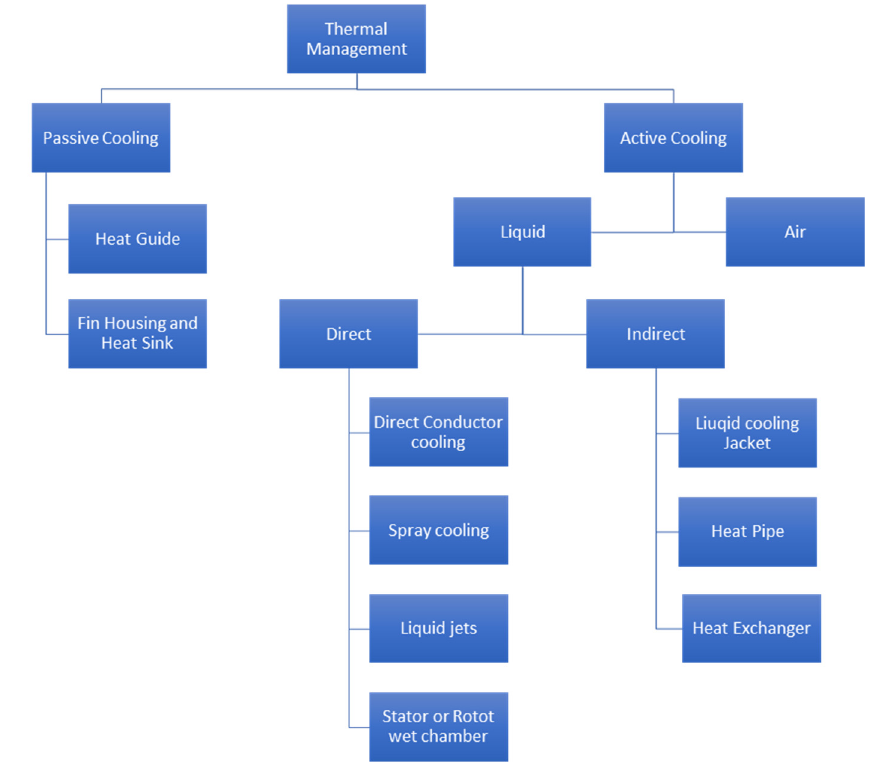
Figure 4. Thermal management methods for electrical machines.